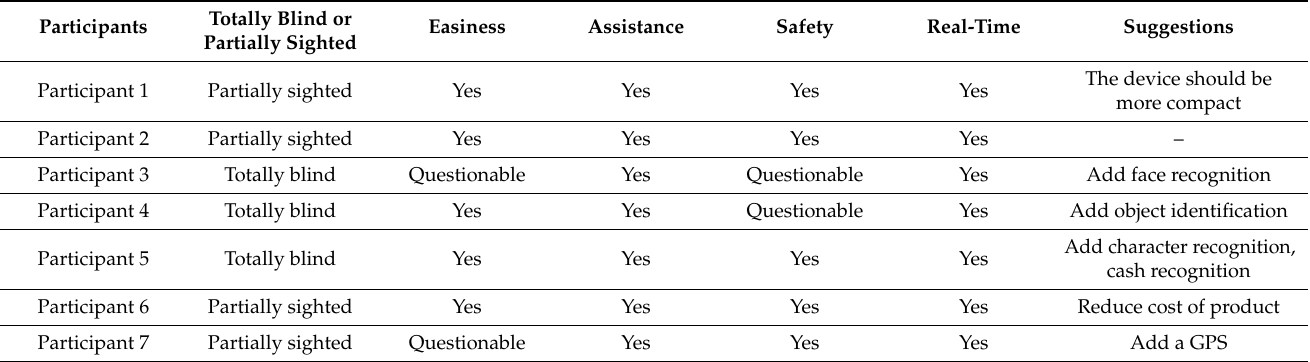
Table 5. The question